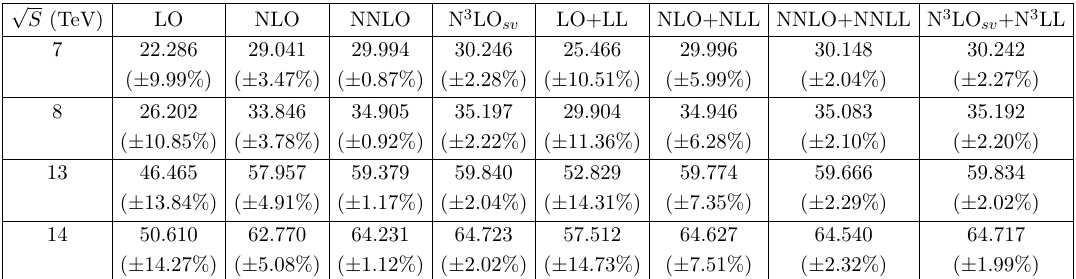
Table 1 . Fixed order (up to N 3 LO sv ) and resummed (up to N 3 LO sv + N 3 LL) cross section (in nb) for on-shell Z -boson production at di(cid:11)erent center of mass energy of LHC. The scale